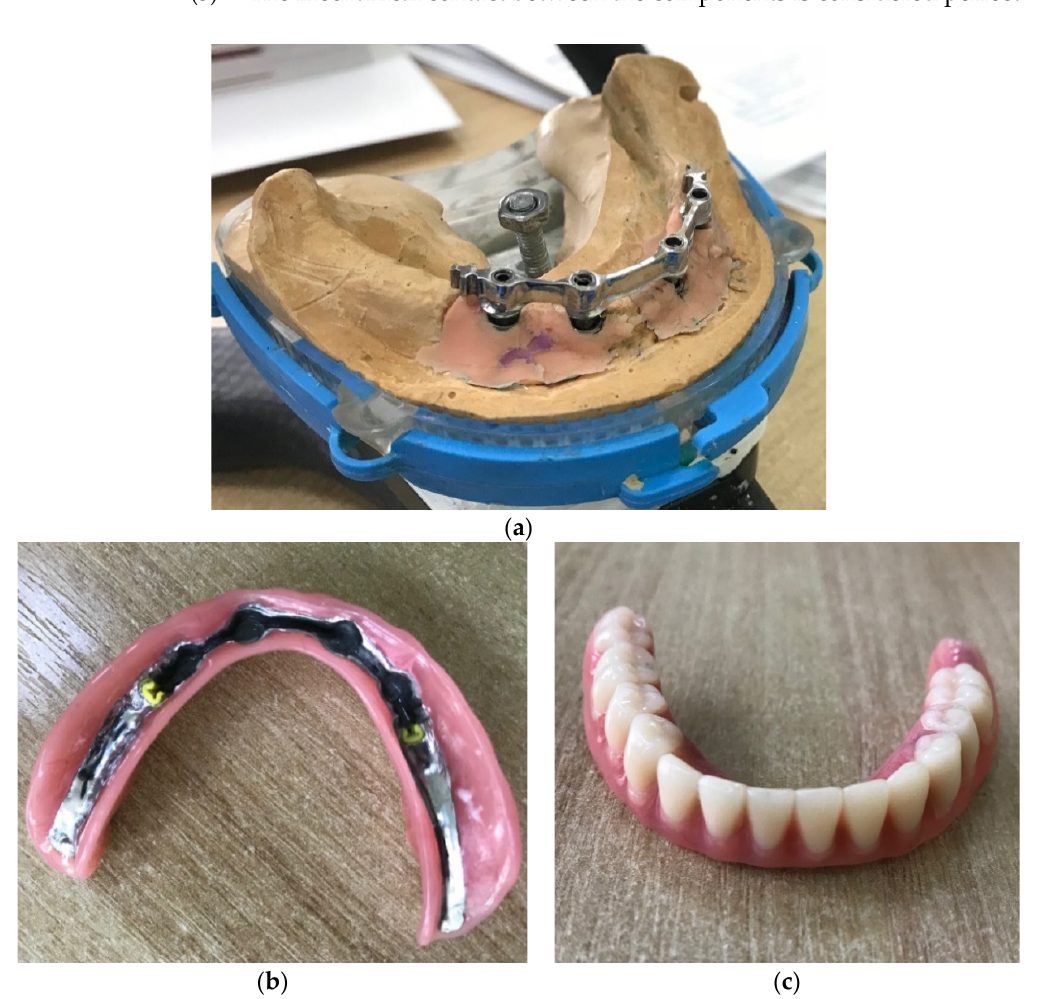
Figure 2. Individual components of the bar structure during the manufacturing process: ( a ) bar, ( b ) secondary overdenture frame, and ( с ) removable overdenture.